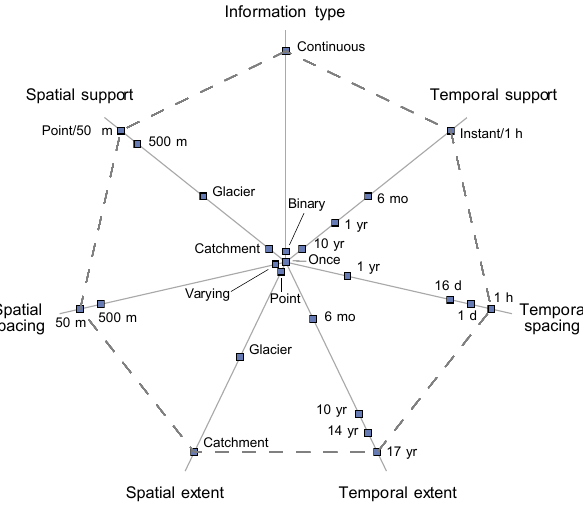
Figure 4. Radar chart axes for the visualization of the observation scale of the used validation data